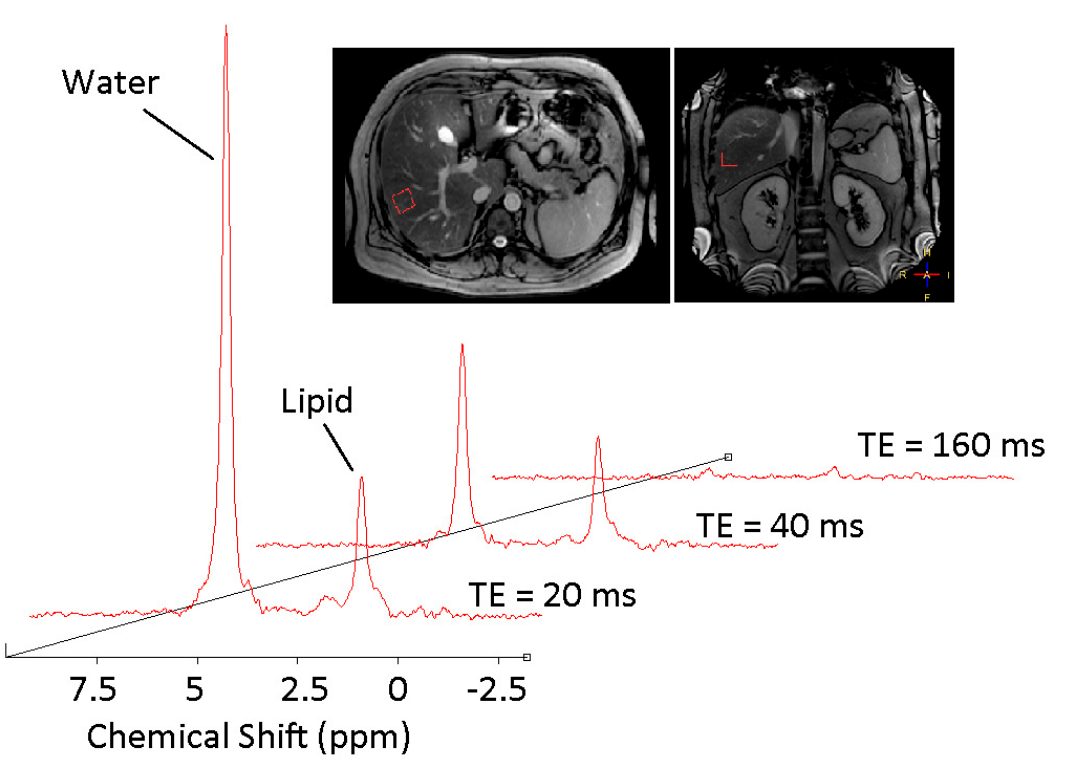
Figure 4. Typical 1 H MR spectra from an individual with NAFLD. The fat fraction is derived from dividing the fat content by the combination of fat and water content. Note that spectra are taken at four different echo times and averaged. Scout images demonstrate localisation within the right lobe of the liver, ensuring the region of interest is placed away from major blood vessels and subcutaneous